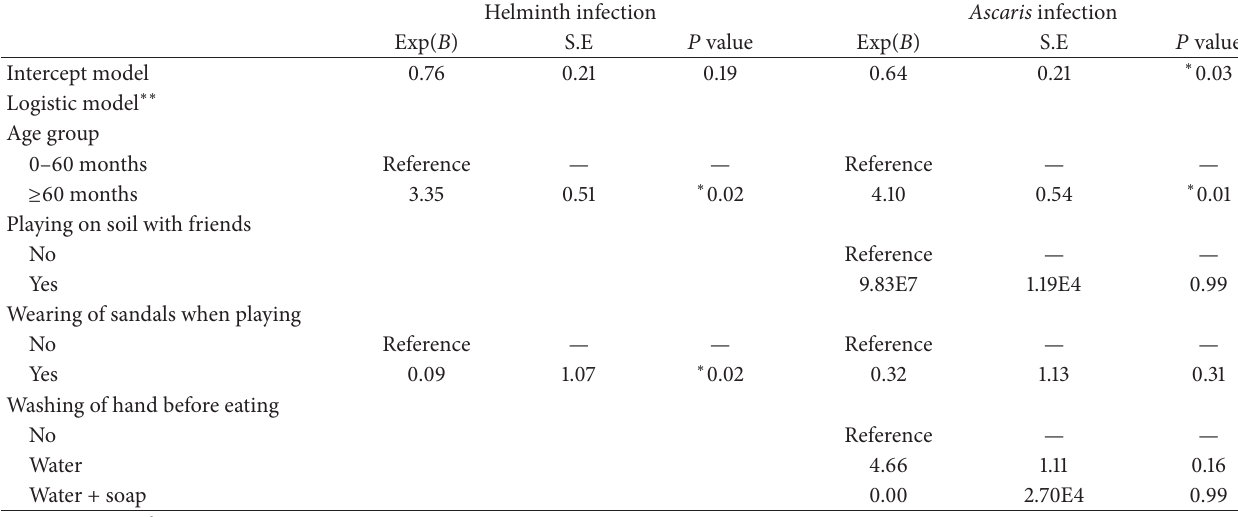
Table 11: Logistic regression models for helminth infection and Ascaris infection.